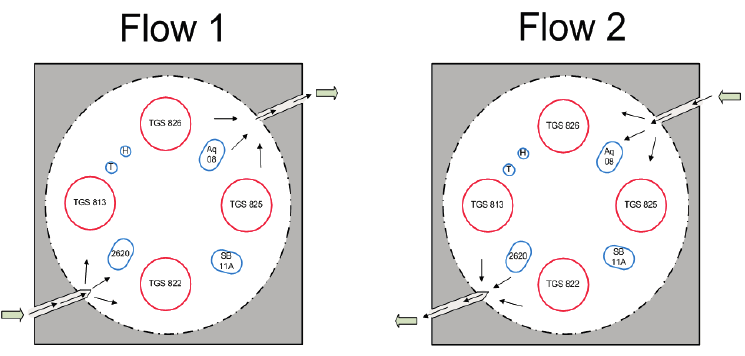
Figure 11. Odor sample flow directions (Flow 1 and Flow 2) into the sensor chamber.